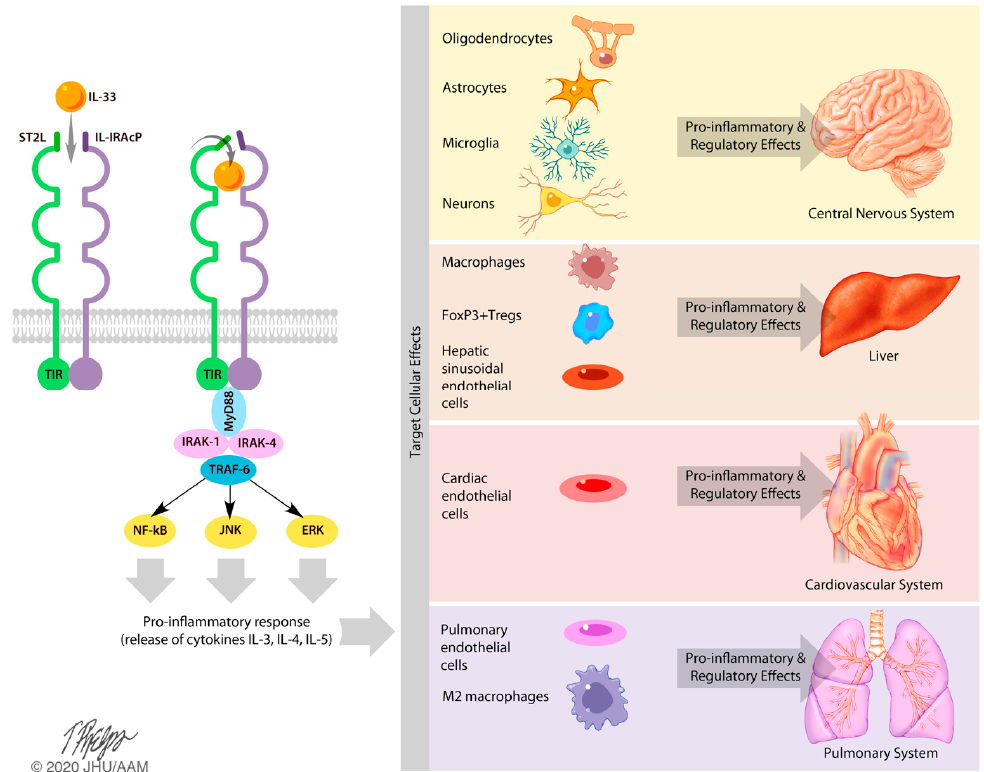
Figure 2. Effects of IL-33, as pro-inflammatory and regulatory, on the central nervous system, liver, cardiovascular system, and pulmonary system. Following activation of the IL-33 pathway, and subsequent activation of NF- κ B, JNK, and ERK/MAPK pathways, a pro-inflammatory response is initiated. This pro-inflammatory response results in the release of cytokines, including IL-3, IL-4, and IL-5. These cytokines act on target cells within the central nervous, hepatic, cardiovascular, and pulmonary systems. Within the central nervous system, activated oligodendrocytes, astrocytes,